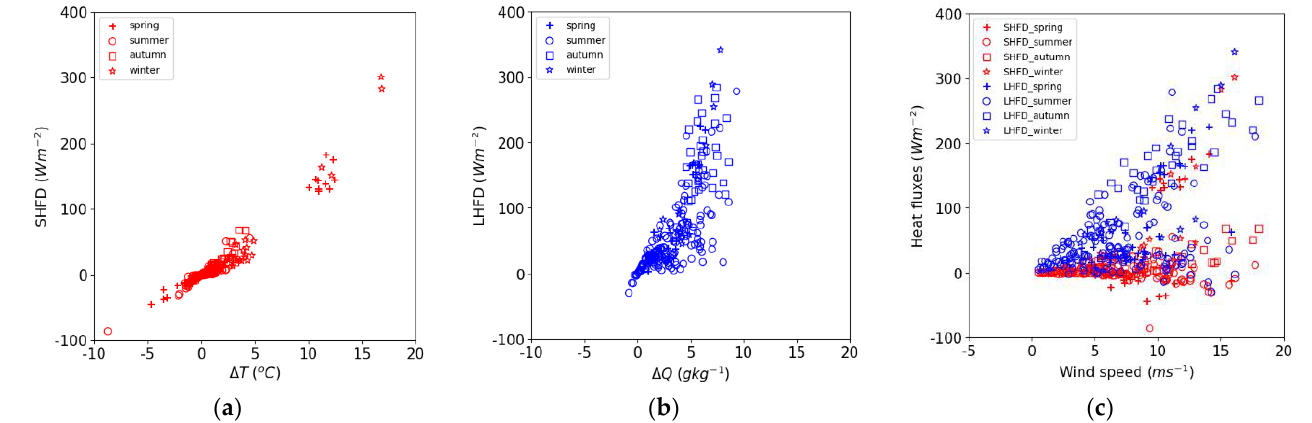
Figure 7. Scatter plots of ( a ) sensible heat flux (SHFD) and ΔT, ( b ) latent heat flux (LHFD) and ΔQ, and ( c ) heat fluxes (SHFD and LHFD) and wind speed. ( a ) sensible heat flux; ( b ) latent heat flux; ( c ) wind effect.